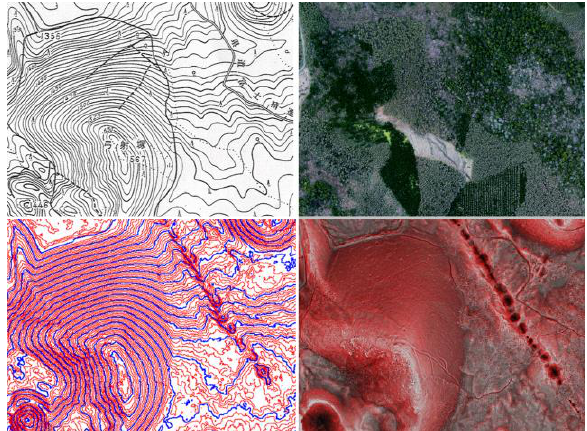
Figure 1. Comparison of RRIM and other methods. a)Contour map; b)Ortho image; c)Contour map from dense LiDAR data; d)